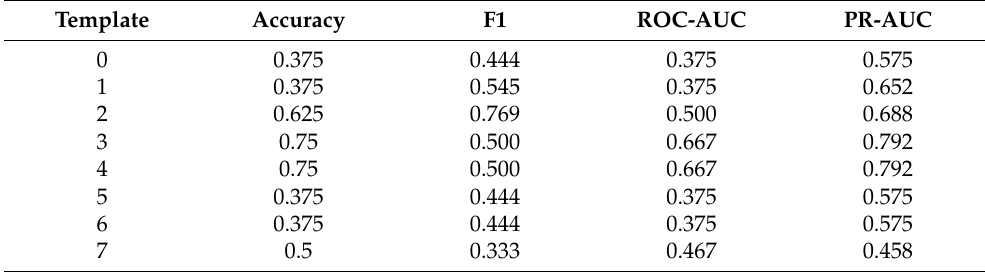
Table 1. Classification in eight test data of unipolar voltage on AF type through LOOCV.